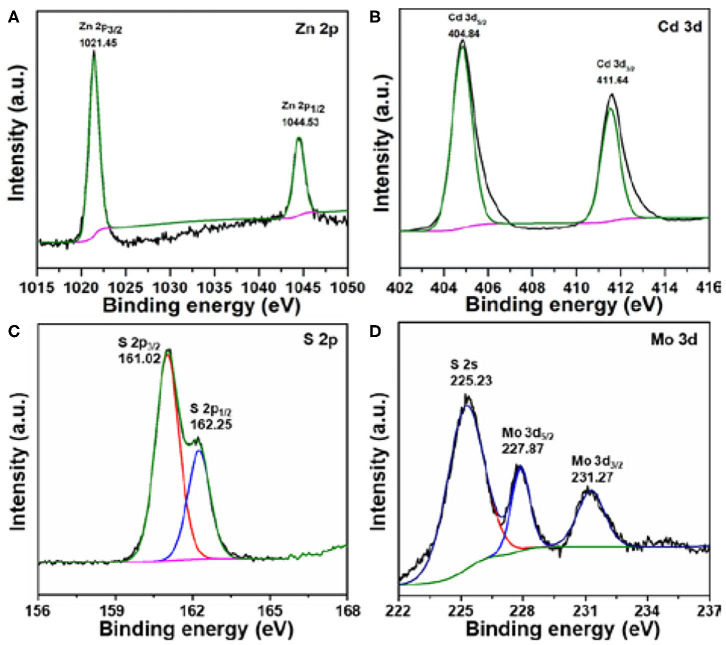
XPS spectra of (A) Zn 2p, (B) Cd 3d, (C) S 2p, and (D) Mo 3d in 0.2% MoS2/Zn0.5Cd0.5S.